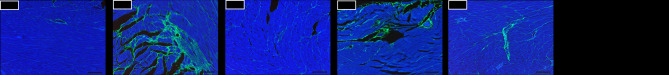
The effects of tannic acid (TA) on cardiac ﬁbrosis as surveyed by Sirius red staining. The staining is shown for the CONT (A), isoproterenol (ISO) (B), PRO (C), low-dose TA (L-TA) (D), and high-dose TA (H-TA) (E) groups (200×; bar 100 μm). (F) Quantification of Sirius red staining expressed as the proportion of the positive area for collagen fibers. Data represent mean ± SEM. Compared to the CONT group (##P < 0.01). Compared to ISO group (*P < 0.05 and**P < 0.01).